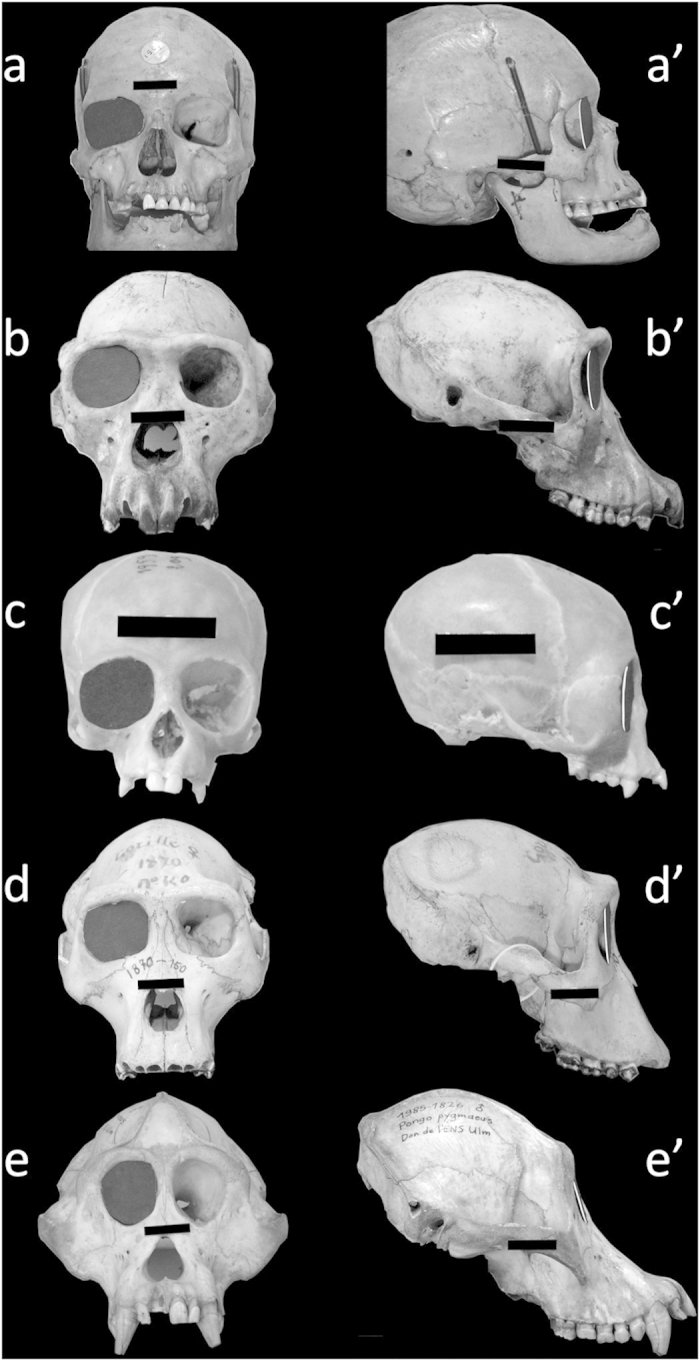
The human orbital margin falls short of being inscribed in a plane.Front and side views of human and ape skulls. A 3-cm wide black landmark affixed to each skull gives the scale. Specimen a/a’ = Homo sapiens; specimen b/b’ = Pan troglodytes; specimen c/c’ = Hylobates muelleri; specimen d/d’ = Gorilla gorilla; specimen e/e’ = Pongo pygmaeus. A black cardboard lid (representing the convergence angle) has been placed in the right orbital plane of each skull. In humans, the lateral orbital margin is far more rearward than the lid (a’) because of the high discrepancy between convergence and opening angles. In non-human apes, this discrepancy is lower and the cap is much closer to the lateral orbital margin (b’,c’,d’,e’). The specimens are from the Natural History National Museum (Paris, France) anthropological collections (a/a’) and Comparative Anatomy Laboratory (b/b’ to e/e’).